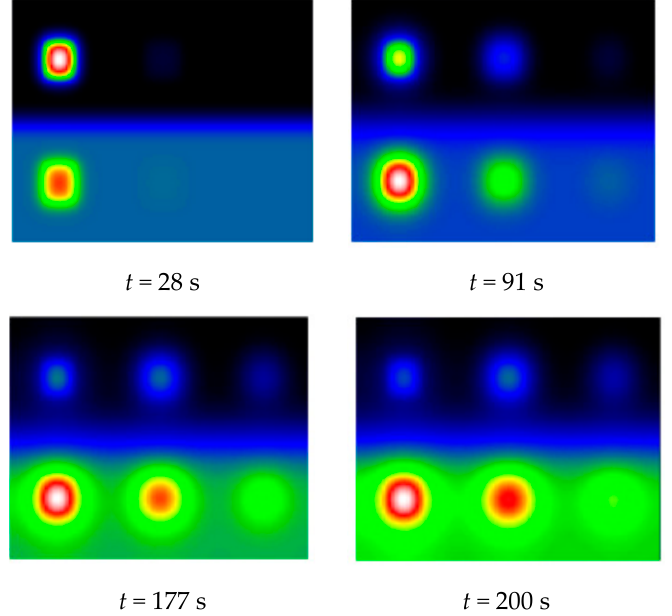
Figure 4. Example of theoretical thermograms obtained (t = 28 s, t = 91 s, t = 177 s and t = 200 s).